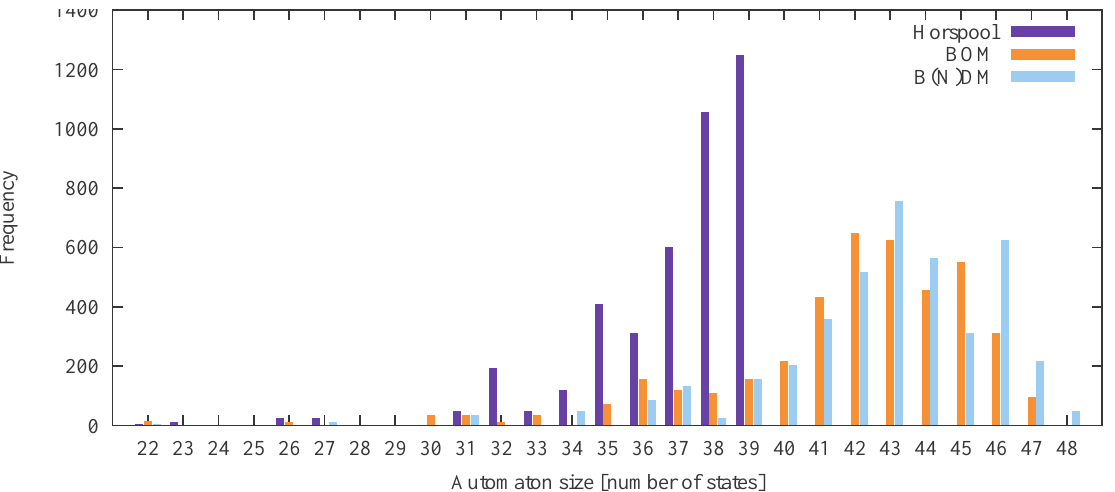
Figure 6. Histogram on number of states of minimal DAAs over all patterns of length 6 over Σ = { A , C , G , T }